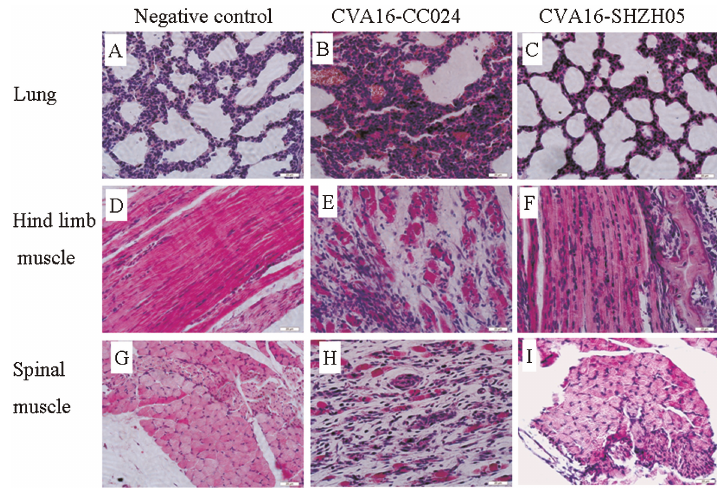
Figure 4. Histological analysis of tissues from Coxsackievirus A16 (CVA16)-infected neonatal mice. One-day-old SPF ICR mice were infected intracerebrally with 20 m L of 10 5.5 CCID 50 /mL of the CC024 or the SHZH05 strain, or mock infected with DMEM. No histological change was observed in the lung tissue, hind limb muscle, and spinal skeletal muscle of the SHZH05 strain-infected ( C , F , and I ) or mock-infected mice ( A , D , and G ). Mice with grade 5 clinical symptoms infected with the CC024 strain virus exhibited severe alveolar shrinkage and vascu- lar congestion (arrow) in the lung tissue ( B ), severe necrosis and loose muscle fibers in the hind limb muscle ( E ) and spinal skeletal muscle ( H ). Magnification 400 6 . All experiments were repeated three times.